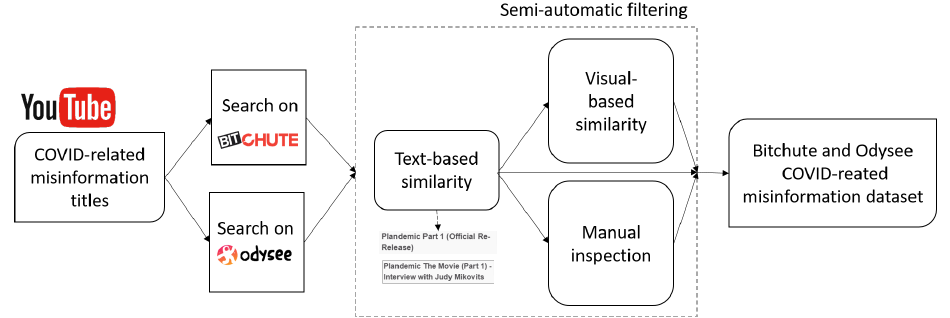
Figure 3. Semi-automatic filtering method